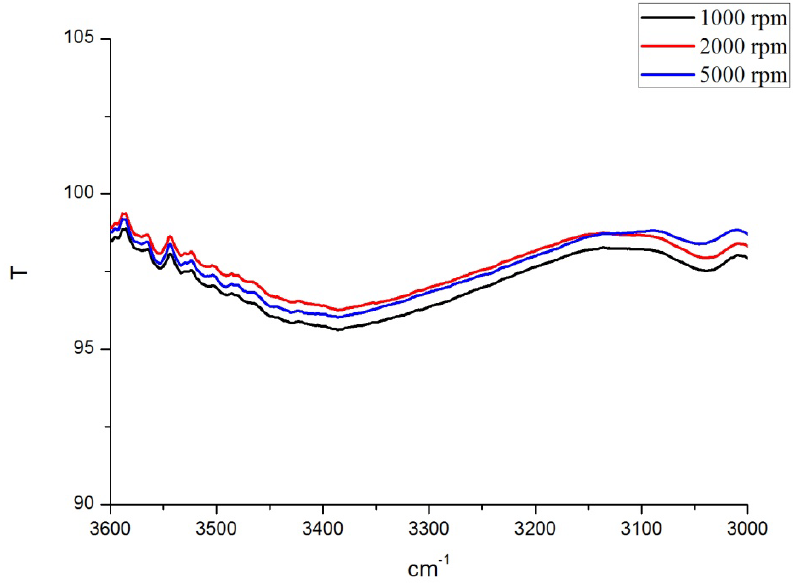
Figure 6. O-H stretching signal of water at the third day of aging in the three resin samples .